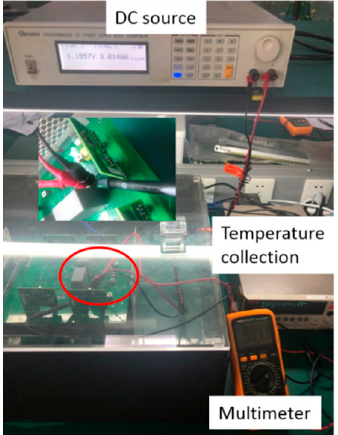
Figure 6. Calibration experiment wiring diagram.